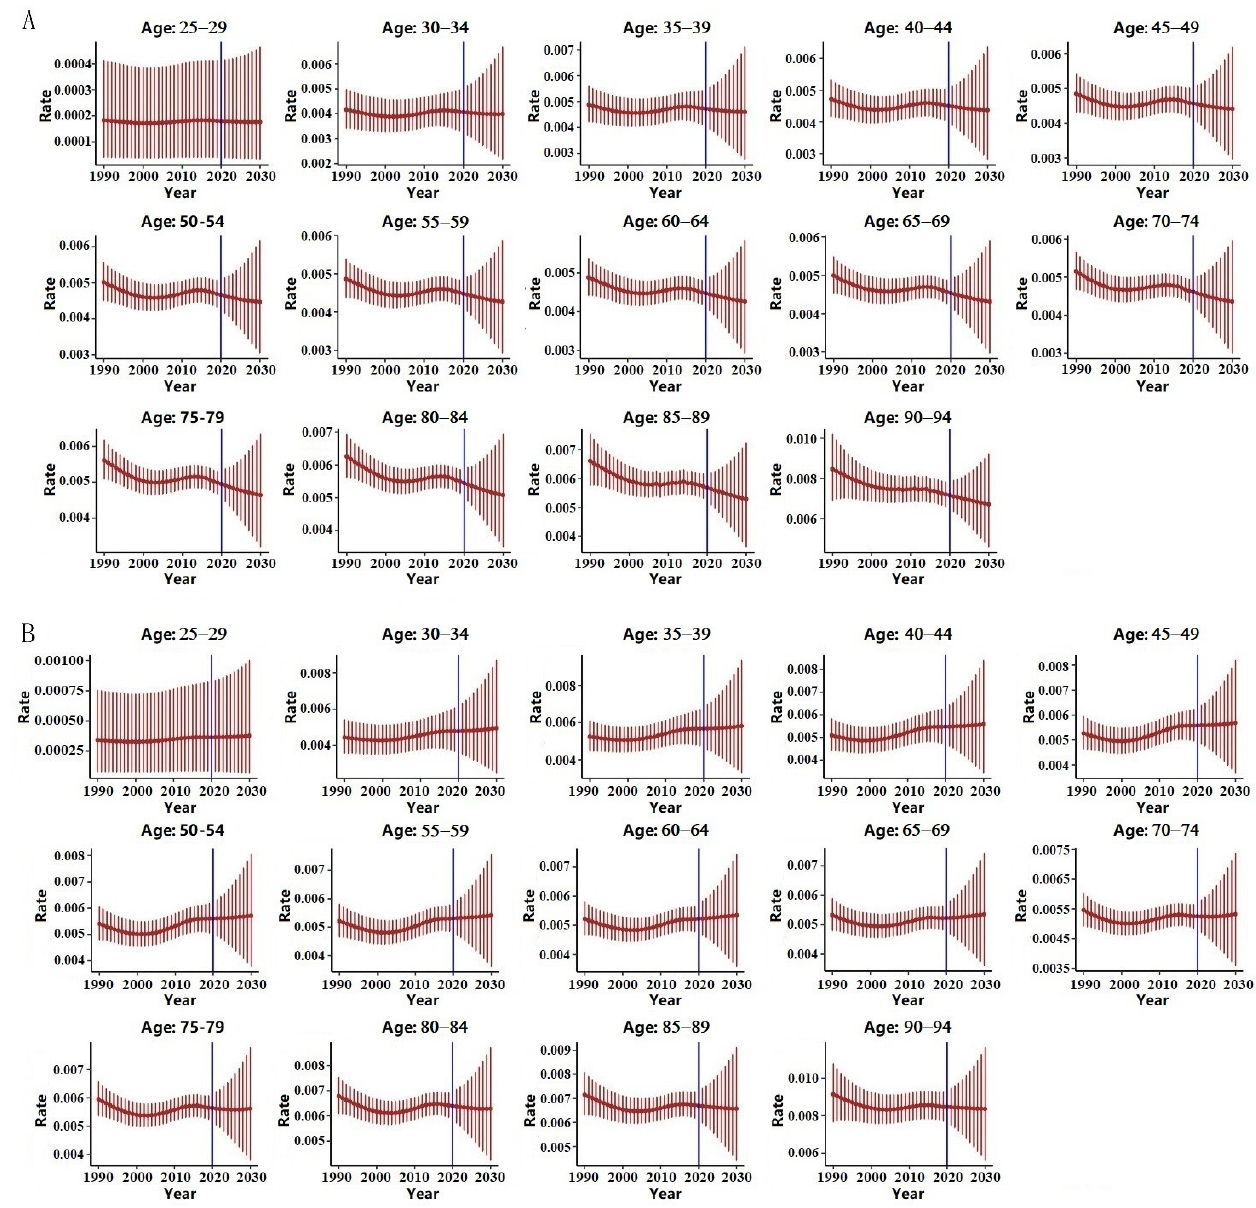
Figure 3. Projected age-specific CRC crude mortality rates (CMRs) based on Bayesian age-period- cohort analysis for both sexes in China from 2020 to 2030. ( A ) Projected CMRs for males; ( B ) projected CMRs for females.